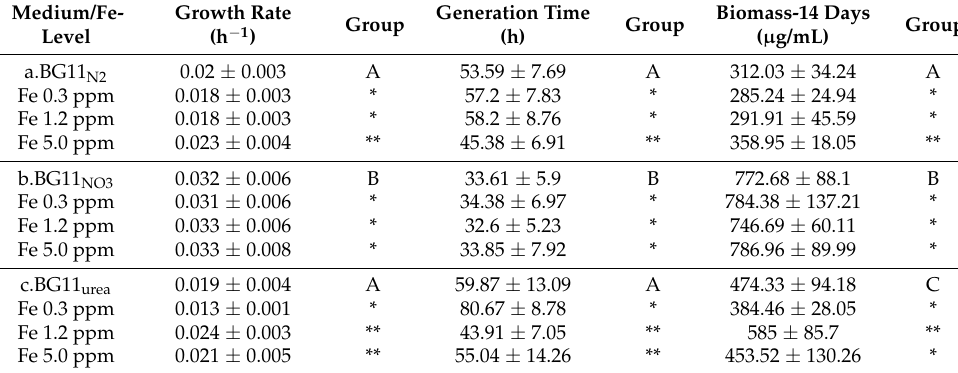
Table 1. Growth and biomass generation of Anabaena in different growth media. Values represent the average and standard errors from three independent biological replicates per Medium–Fe level treatment. Biomass data correspond to the biomass generated over 14 days of growth. Two-way anal- ysis of variance (ANOVA) was used to analyze statistically significant differences with a significance level α = 0.05. Medium type and Fe-level were used as independent predictors. Medium levels not connected by same group letter are significantly different. Fe-levels not connected by same number of stars within medium type are significantly different. Growth rate (Medium p -value = 0.0050; Fe level p -value = 0.4102; interaction p -value = 0.7536), Generation time (Medium p -value = 0.0037; Fe level p -value = 0.1419; interaction p -value = 0.1918), biomass-14 days (Medium p -value < 0.0001; Fe level p -value = 0.6376; interaction p -value =